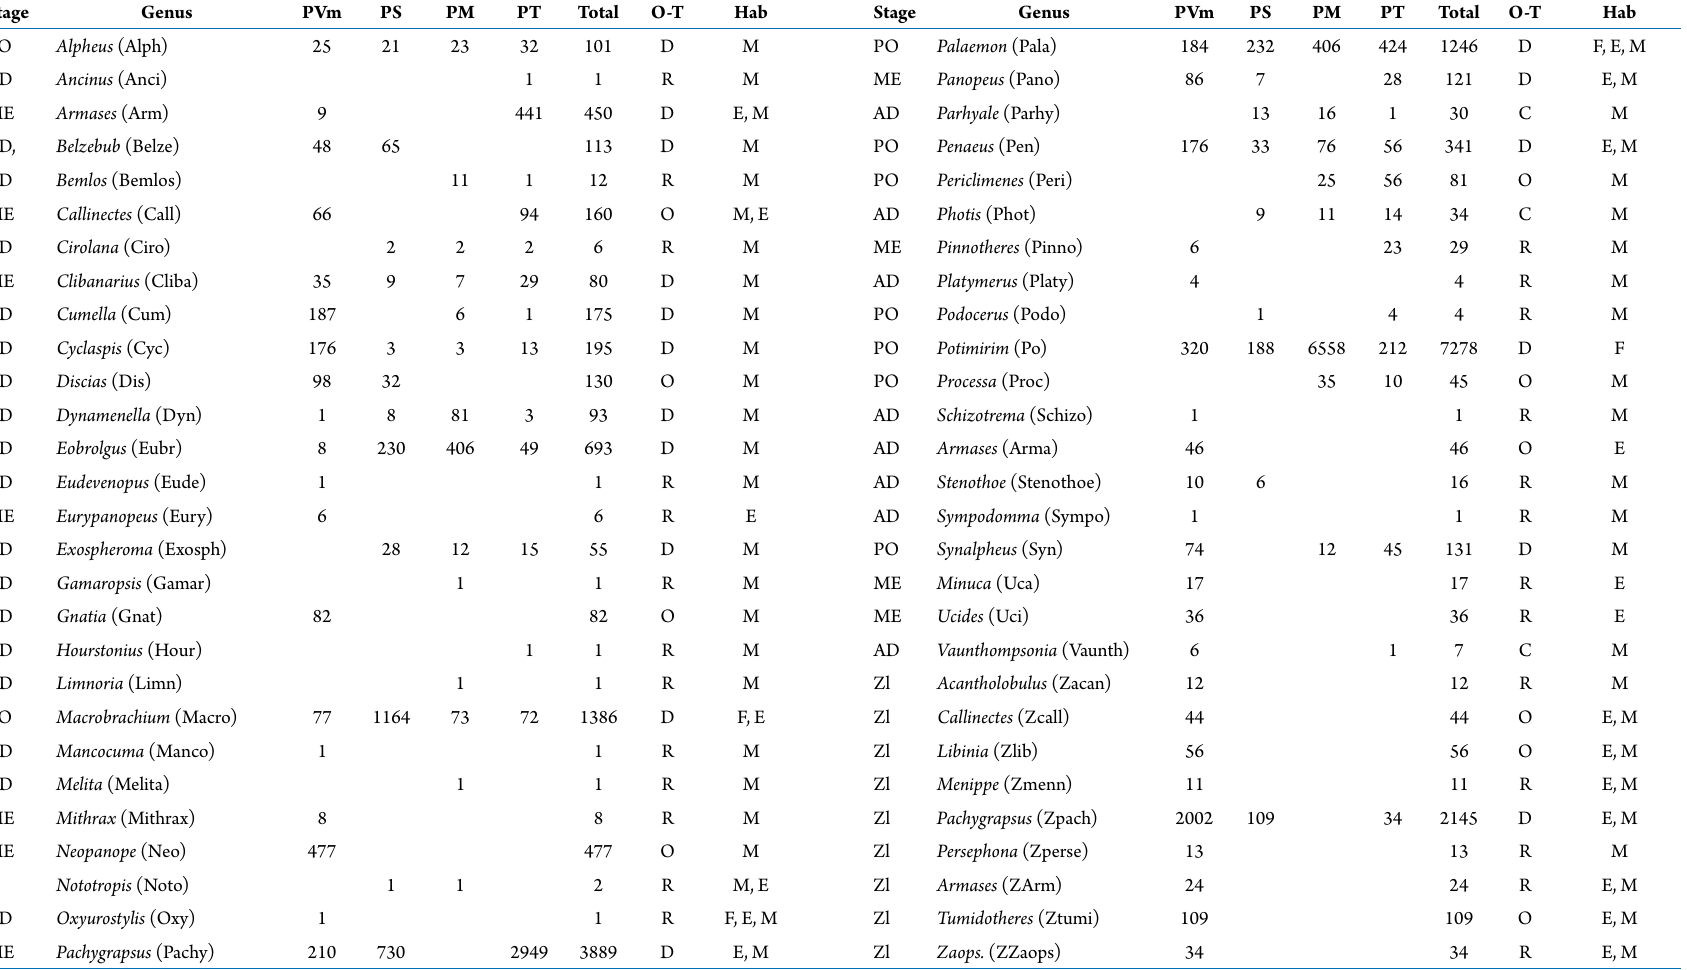
Table 3. Abundance of larvae and macro-crustaceans in four sites on the coastline of the Parque Nacional Sistema Arrecifal Veracruzano. AD, adult; D, dominant; E, estuarine; F, freshwater; Hab, habitat; M, marine; ME, megalopa; O, occasional; O-T, Olmstead-Tukey; PM, Playa Martí; PT, Playa Tortugas; PO, postlarva; Ps, Plaza de la Soberanía; PVm, Playa Villa del Mar; R, rare; Z1, zoea